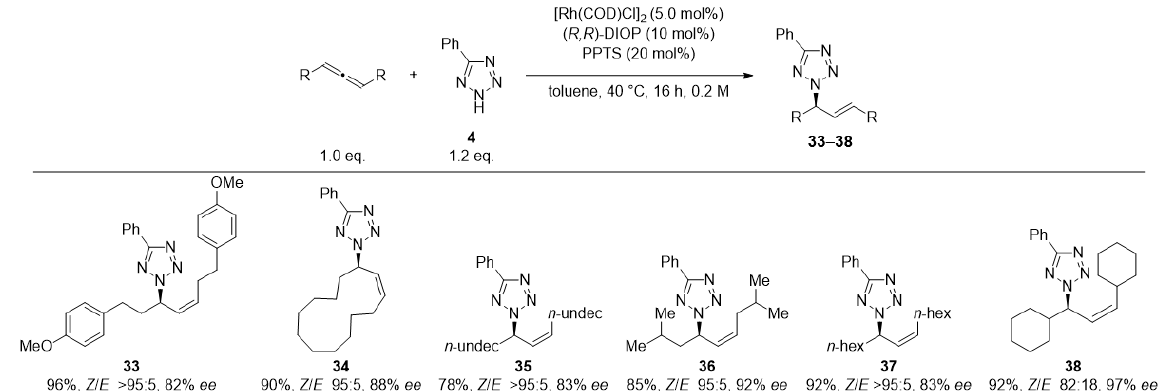
Figure 5. Scope of the addition of 5-phenyl-2H-tetrazole to different racemic allenes. Reactions were performed at 0.25 mmol scale. Cumulative yield for all isolated isomers. E/Z -selectivities determined by 1 H-NMR. Enantioselectivities were determined by HPLC analysis using a chiral stationary phase. Unless specified, ee -values refer to main-stereoisomer of the main-regioisomer. Unless specified full N 2 -selectivity was